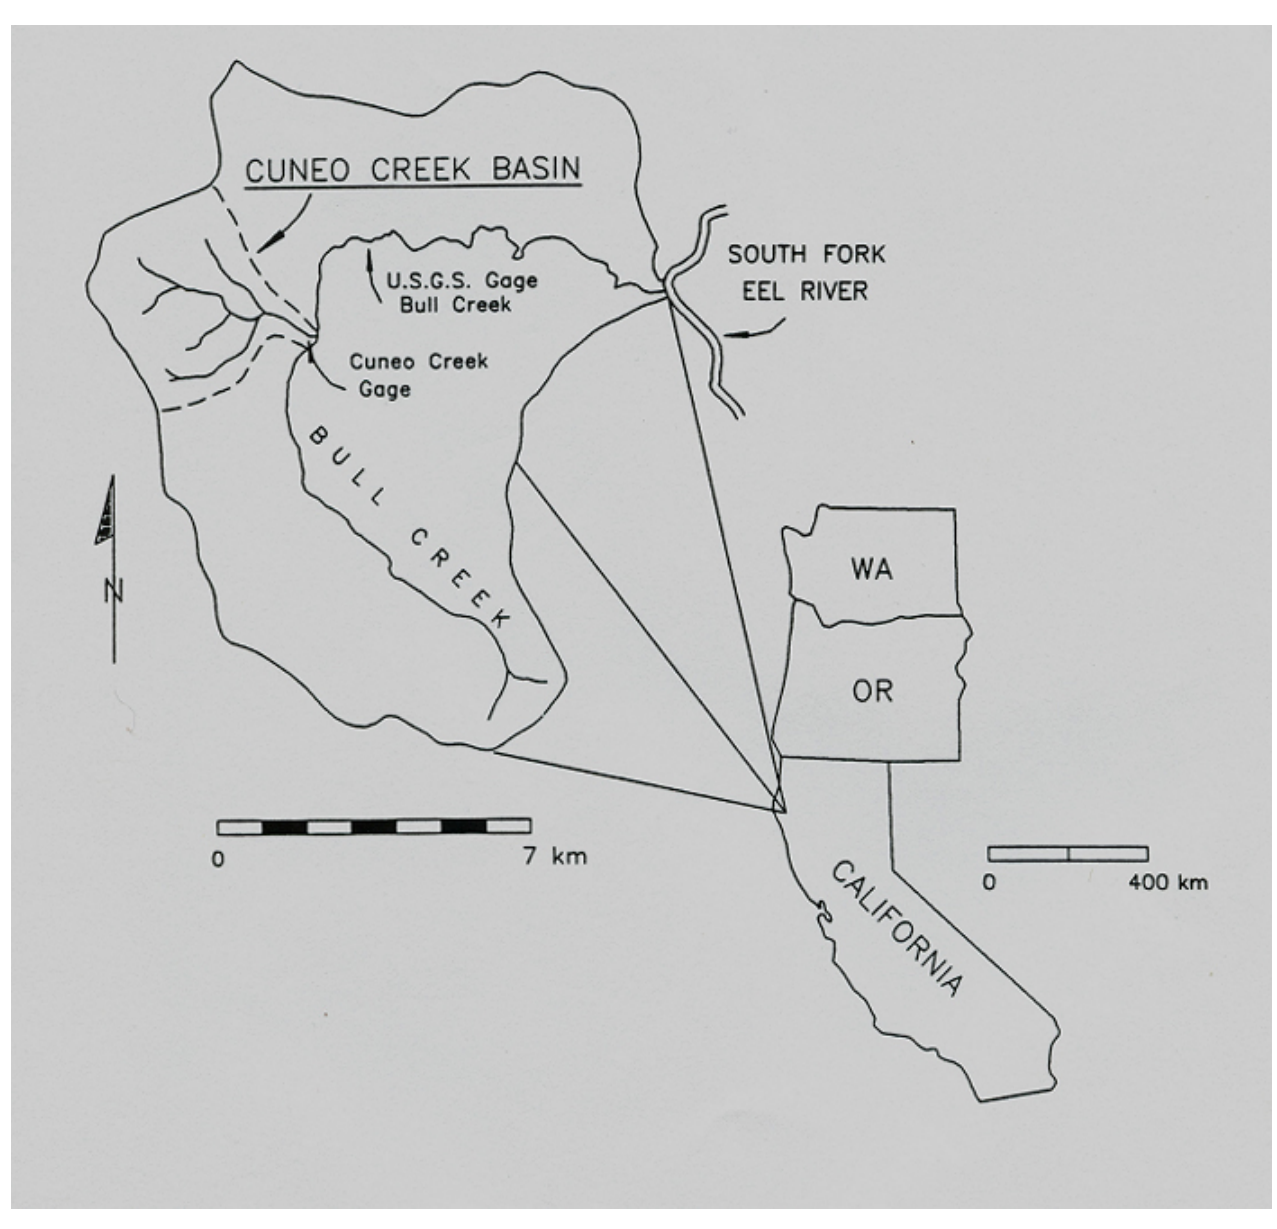
Fig. 2 . Location map, Cuneo Creek (from Short